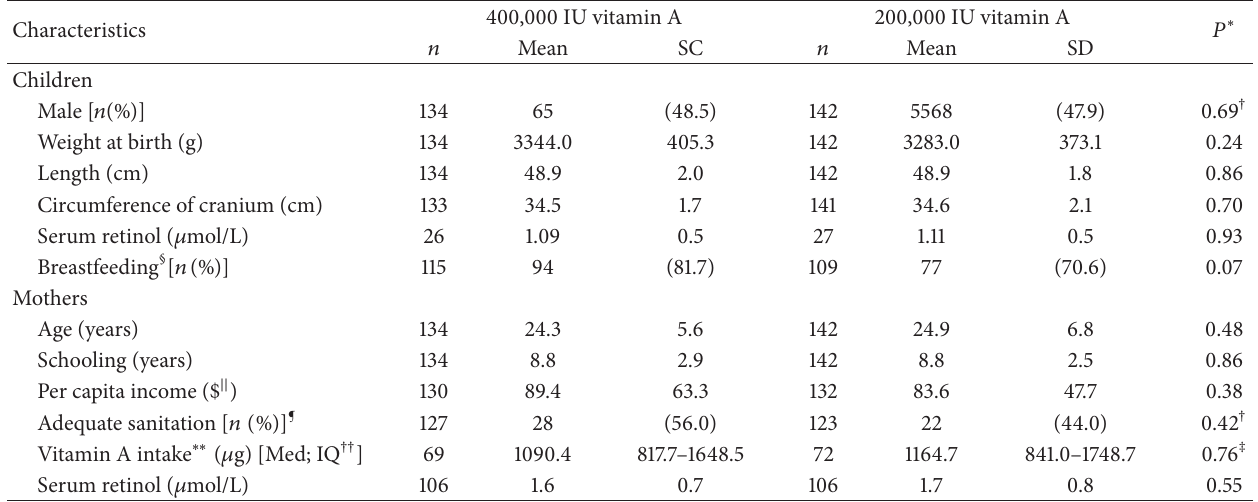
Table 1: Baseline characteristics of mothers and children, Recife, Brazil, 2008-2009.